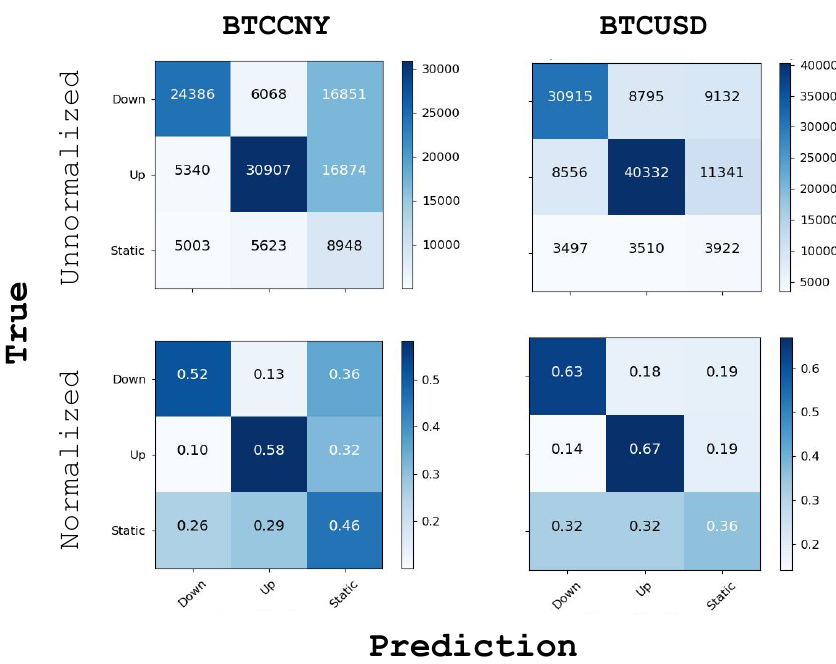
Figure 8. Confusion matrices (RSM). Refer to Figure 7 for the axis labels. As compared to the confusion matrices of an LSTM network, it can be seen that our model was less biased to the static class.